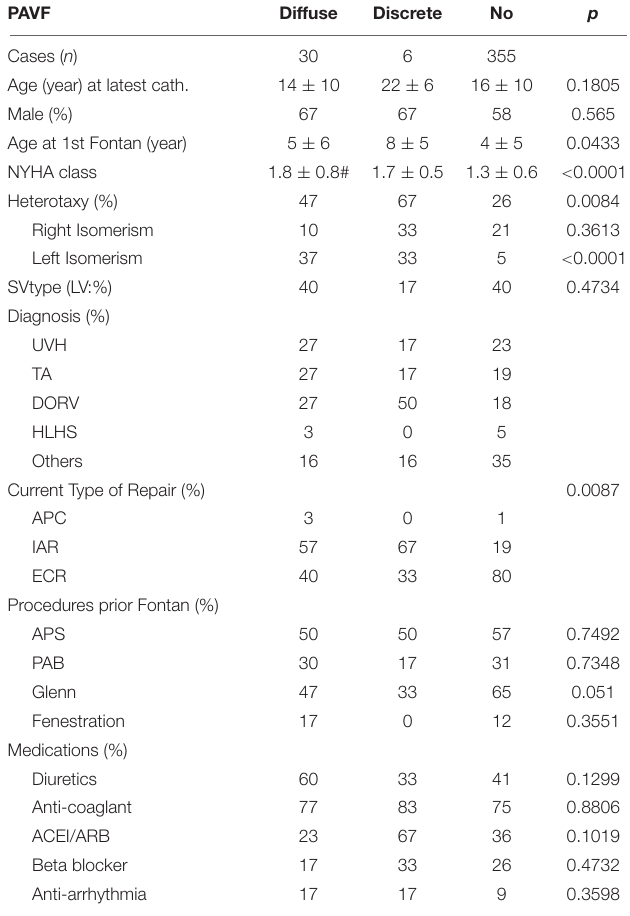
TABLE 1 | Subject